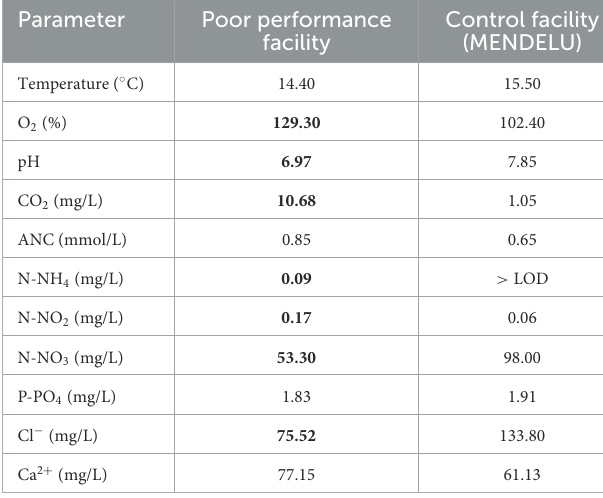
TABLE 1 Water quality parameters comparing conditions at a poorly performing salmonid aquacultural facility and those at a control facility (MENDELU), based on ten measurements at each